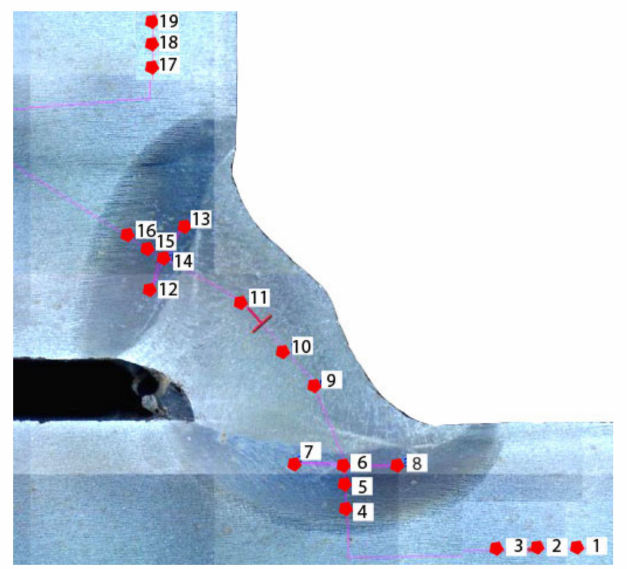
Figure 4. The distribution of measurement